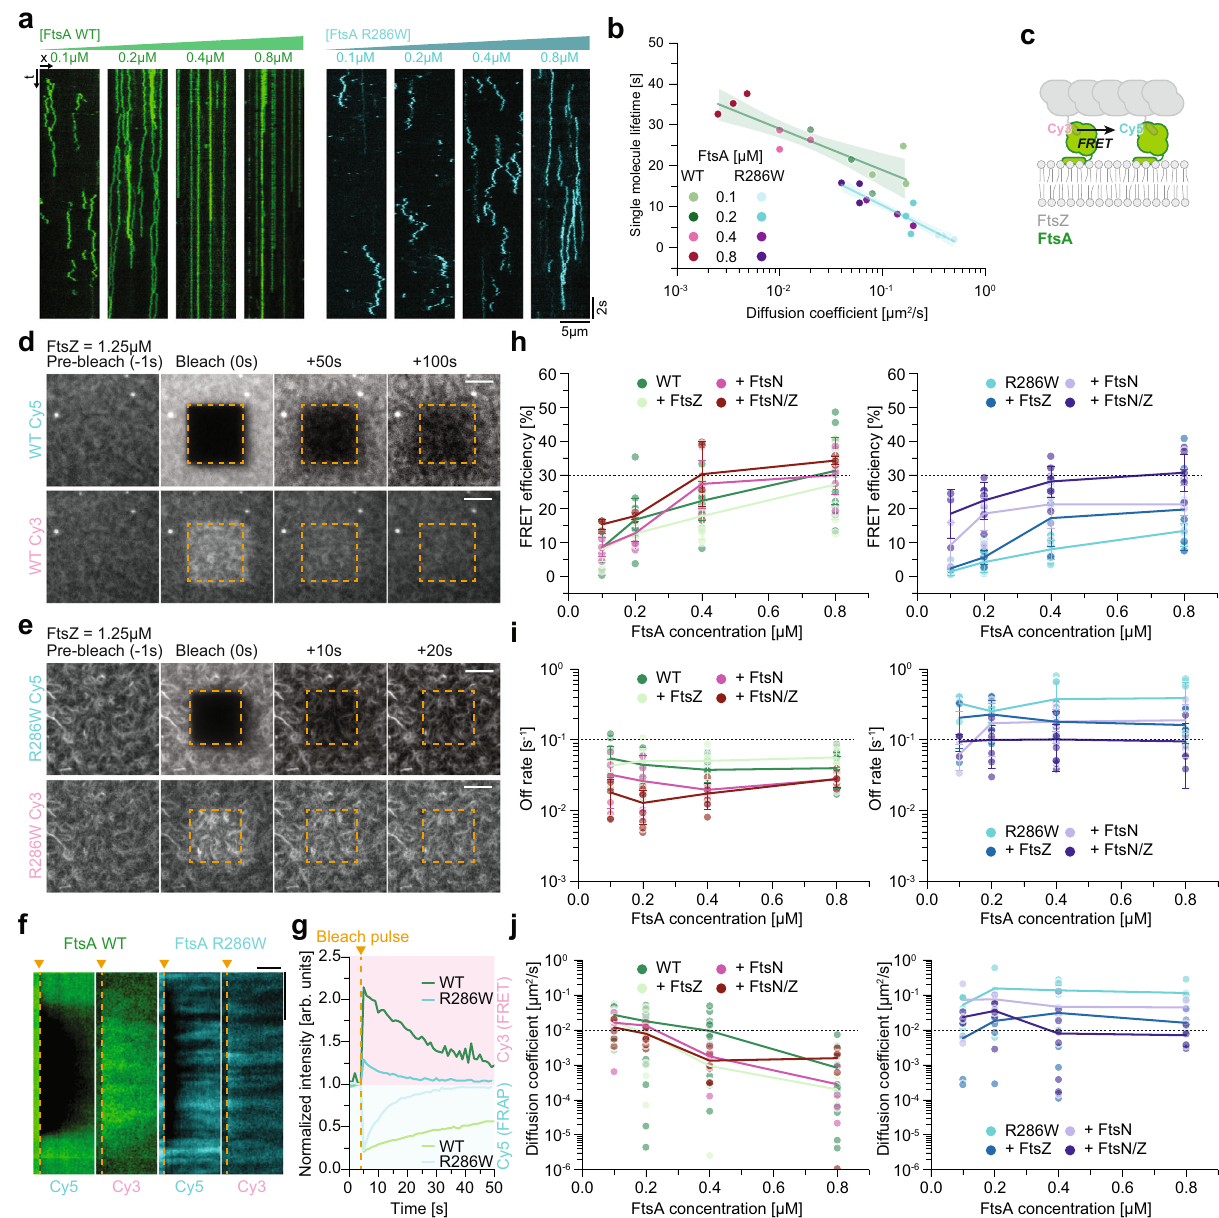
Fig. 3 FtsA R286W shows faster membrane exchange than FtsA WT, while the self-interaction of both proteins is enhanced in the presence of FtsN cyto . a Representative single-molecule kymographs of Cy5-FtsA WT (green) and Cy5-FtsA R286W (cyan) at increasing concentrations. b With higher concentrations the mobility of both proteins decreases and the residence time increases, but R286W remains 10x more mobile and has a 2-7x lower lifetime. Thick line indicates the mean value, shaded area represents 95% con fi dence interval; n = 3. c Schematic of the experiment to measure FRET between Cy3-FtsA (donor) and Cy5-FtsA (acceptor). d , e Representative montage of acceptor photobleaching experiment with FtsA WT ( d ) or R286W ( e ). Scale bars are 5 µ m. f Kymographs from acceptor photobleaching experiments, and corresponding donor signal for FtsA WT (green) and R286W (cyan). Scale bars are 4 µ m and 20 s, respectively. g Representative curves showing acceptor (top) and donor fl uorescence intensities (bottom) for FtsA WT (green) and R286W (cyan). h Left: FtsA WT FRET increases at higher concentrations, FtsZ slightly decreases, while FtsN cyto and FtsZ/FtsN cyto increase FtsA self-interaction. Right: FtsA R286W FRET increases with concentration, but is signi fi cantly lower than for WT. FtsZ and FtsN cyto increase FRET, and with both the FRET signal of WT and R286W are indistinguishable. i Left: Off-rates remain slow with increasing concentrations of WT. FtsN cyto and FtsN cyto /FtsZ further decrease the exchange. Right: Off-binding rates remain constantly high with increasing concentrations of FtsA R286W. FtsN cyto and FtsN cyto /FtsZ decrease the rate, but it remains higher than for WT. j Left: D coeff drops with increasing FtsA WT concentrations and decreases further with FtsZ and FtsN cyto . Right: D coeff remains unchanged at increased concentrations of FtsA R286W. FtsN cyto and FtsZ slow down R286W, which remains more mobile than WT. Dots in all plots represent independent experiments, thick lines indicate the mean and error bars depict the standard deviation. Source data are provided as a Source Data fi